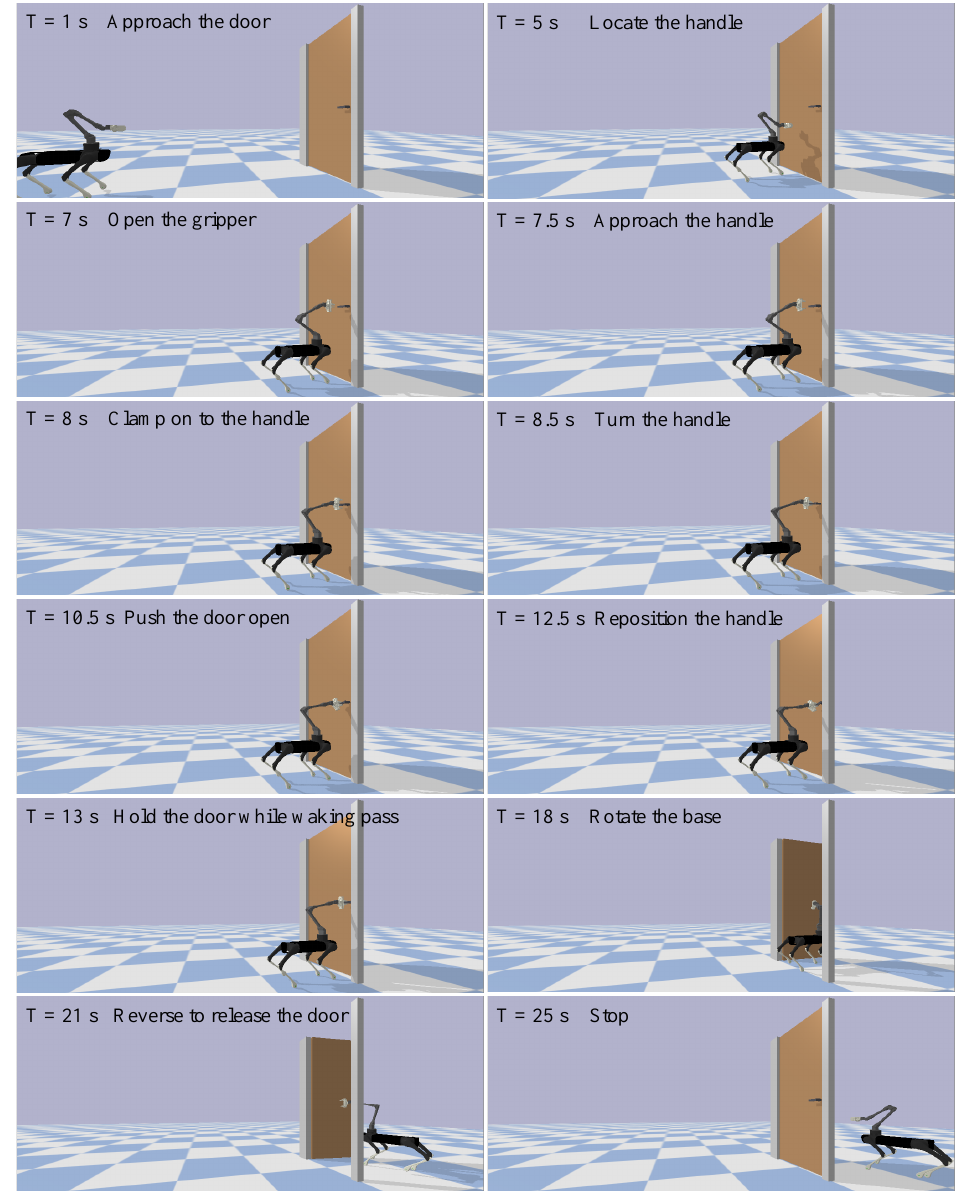
Figure 9. Snapshots of the robot opening a spring-loaded